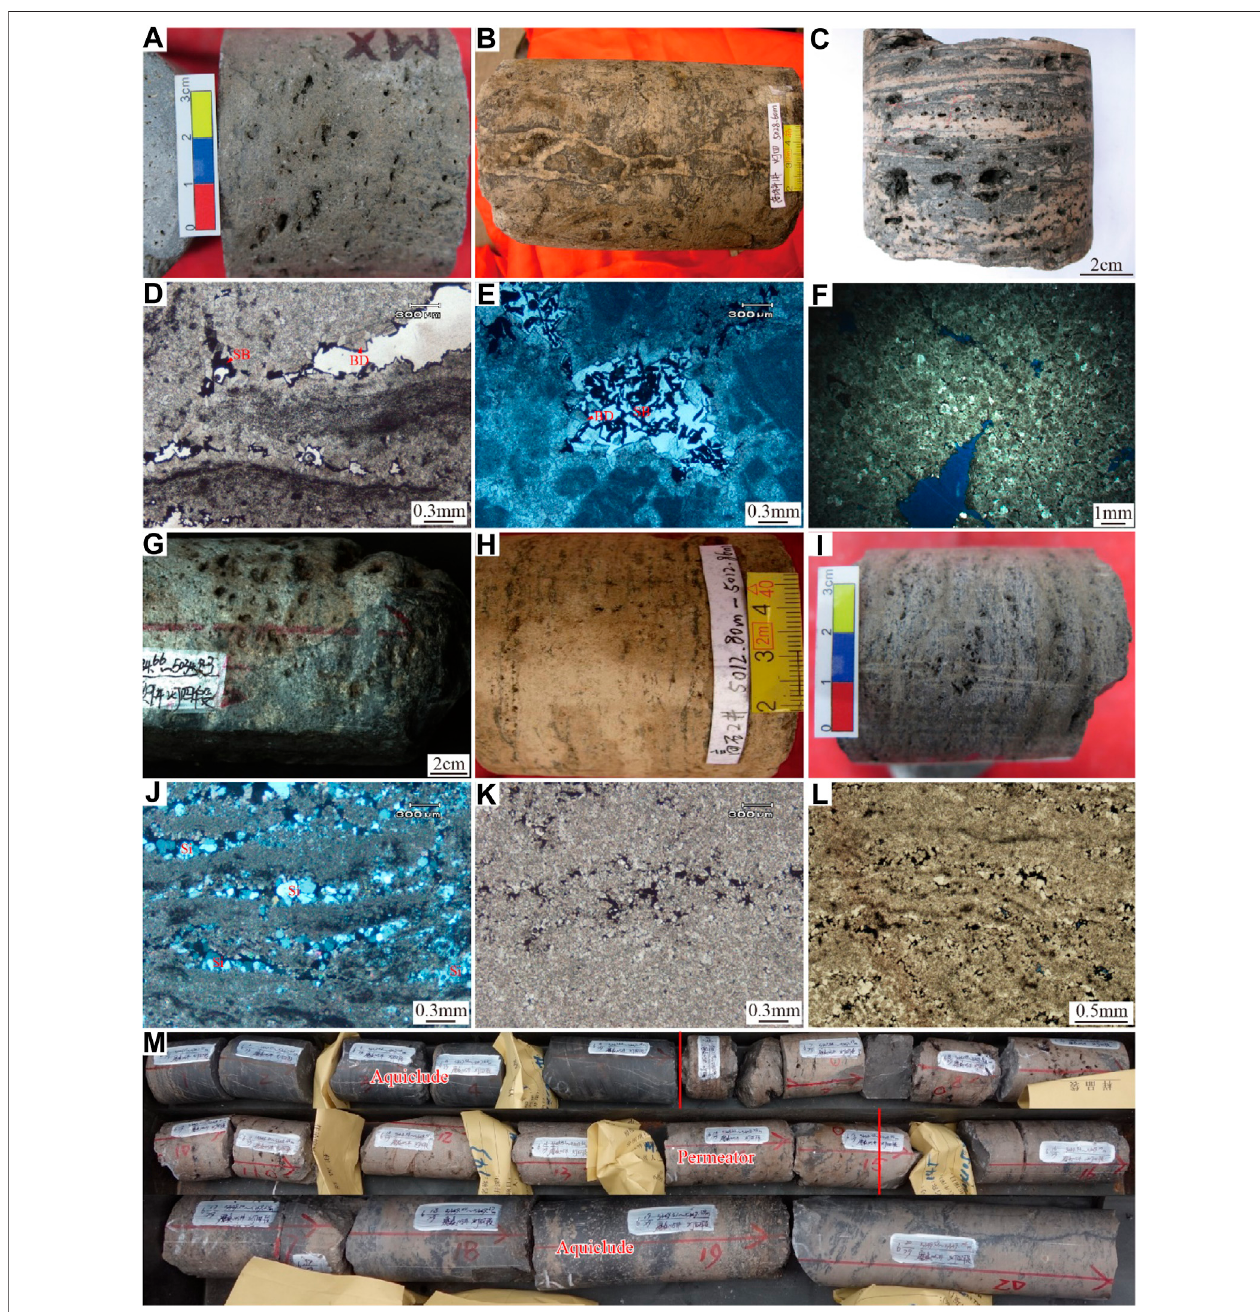
FIGURE 8 | Macro and microscopic karst features of slope terrain and fl at topography. (A) honeycomb-like vugs, borewell M109, 5,110.17 m; (B) vadose grike hatched by breccias, mud, and dolomites, borewell GK1, 5,028.35 m; (C) stromatolithic dolomite, horizontally elongated vugs distributed along laminae, borewell GK1, 5,150.58 m; (D) stromatolite, framework vugs half- fi lled by bladed dolomite and solid bitumen, borewell GK1, 5,149.58 m, plane-polarized light; (E) microbial micritic boundstone, solution pore half-hatched by bladed dolomite and solid bitumen, borewell GK1, 5,145.1 m, plane-polarized light; (F) granular dolostone, solution pore nearly un fi lled, borewell M109, 5,107.43 m, plane-polarised light; (G) locally concentrated honeycomb-like vugs and pores, borewell M9, 5,034.66 – 5,034.83 m; (H) solution pinholes distributed along laminae, borewell G2, 5,012.8 – 5,012.86 m; (I) laminated dolomite, solution pinholes arranged along laminae, borewell G18, 5,134.2 m; (J) stromatolite, laminated framework vugs fi lled by silica, borewell AP1, 5062 m, cross-polarized light; (K) coarse-powder crystalline dolostone, horizontally distributed solution pinholes fi lled by fi ne crystalline dolomite and solid bitumen, borewell AP1, 5,053 m, plane-polarized light; (L) stromatolite, inter-laminae solution pores fi lledby fi ne-crystallinedolomiteandsolidbitumen,borewellG2,5,013.99 m,plane-polarizedlight; (M) verticalalternationofaquicludeandpermeator,manifesting control of sedimentary facies on karsti fi cation, borewell M105, 5,347.27 – 5,349.74 m (this photograph is cited from a Sinopec PPT).